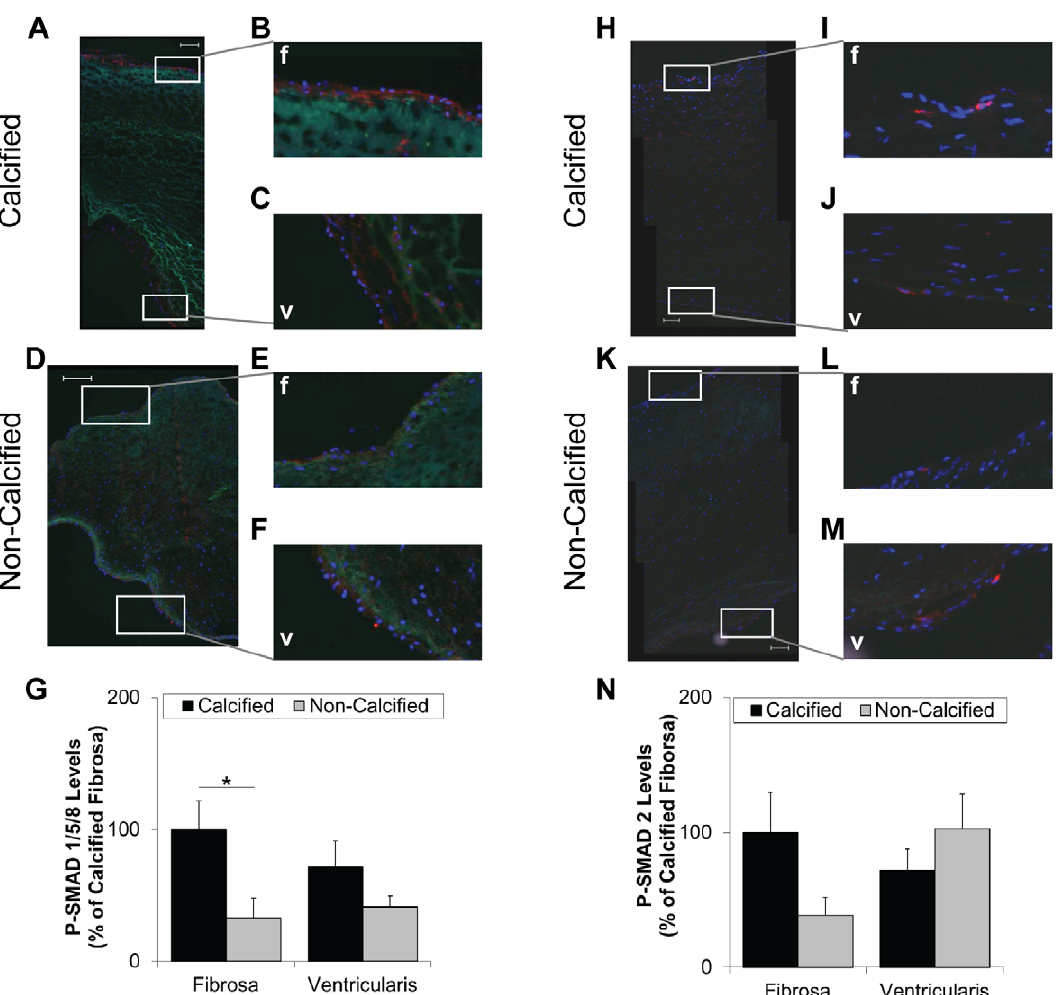
Figure 2. Phospho-SMAD 1/5/8 level is high in calcified fibrosa endothelium. Calcified and non-calcified AV sections were stained for phospho-SMAD 1/5/8 ( A–F ), and phospho-SMAD 2 ( H–M ), and a rhodamine-labeled secondary antibody. Shown are representative images. Bar graphs show staining intensities of fibrosa- and ventricularis-endothelium for each SMAD ( G , N ) (mean + SEM). For phospho-SMAD 1/5/8, n=13 calcified and n=12 non-calcified. For phospho-SMAD 2, n=14 calcified and n=13 non-calcified. For SMAD-6, n=22 calcified and n=15 non-calcified. *p , 0.05, # p , 0.06. f: fibrosa, v: ventricularis.